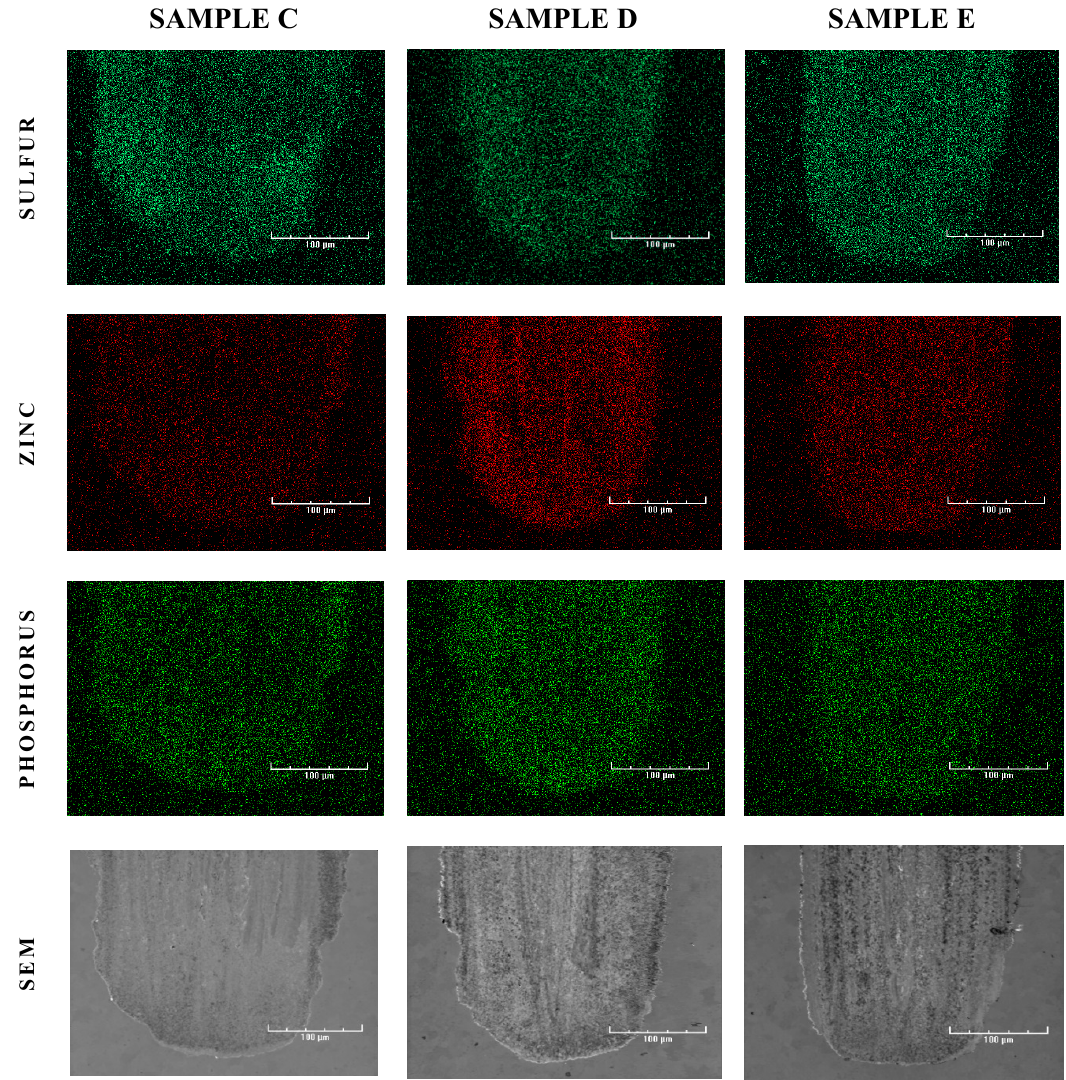
Figure 8. Electron diffraction spectroscopy (EDS) signal for sulfur, zinc and phosphorus in the friction tracks of sample plates C, D, and E, and the corresponding SEM images (bottom row).